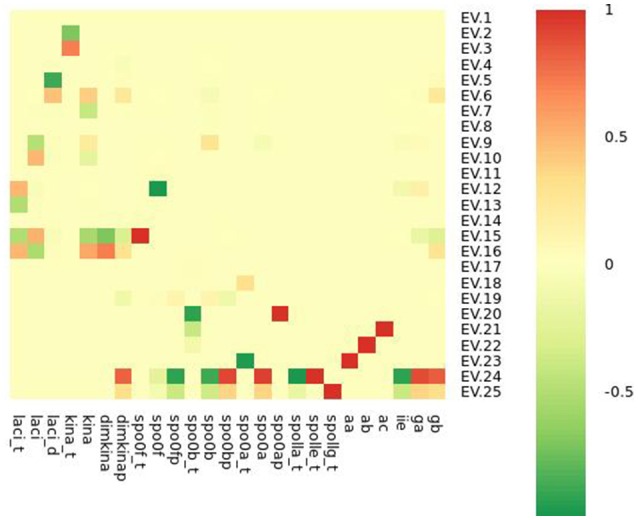
Heatmap representation of the Jacobian matrix eigenvectors (EVs) evaluated at the steady state point reported in Table 3.